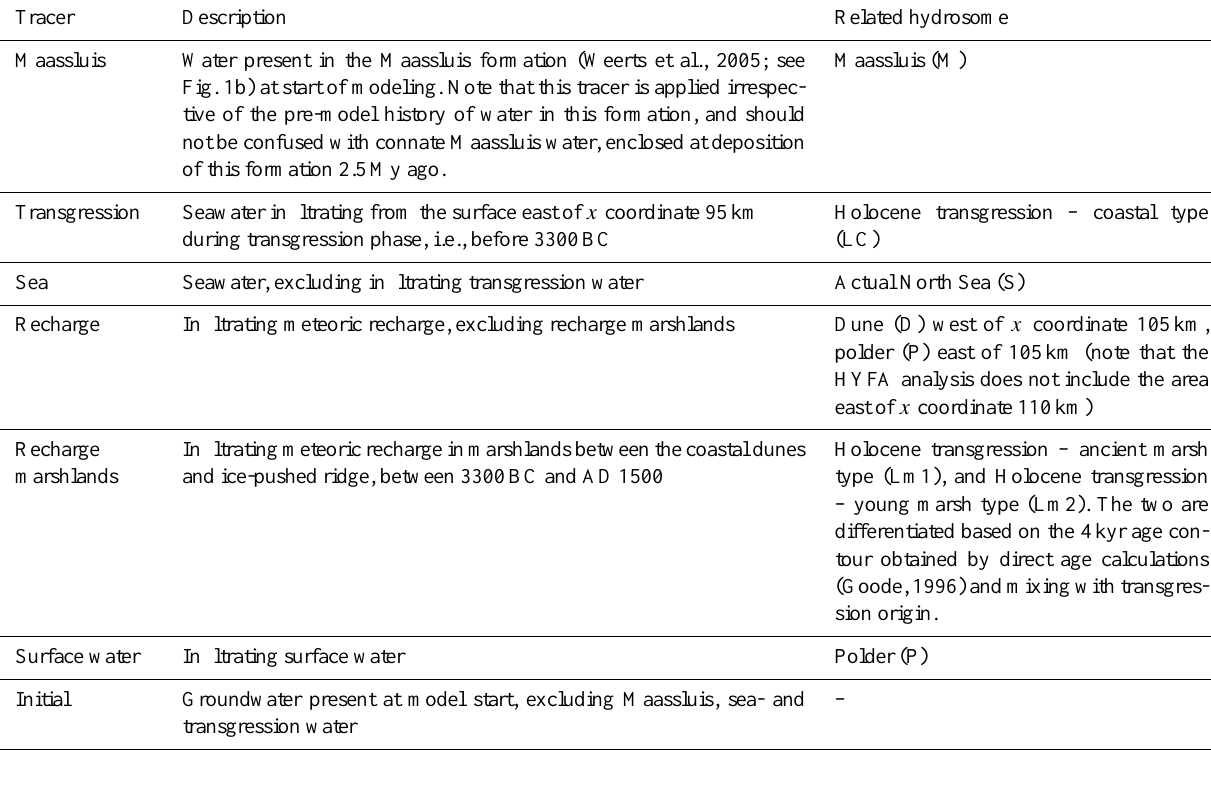
Table 2. Description of model time slices. Time slice